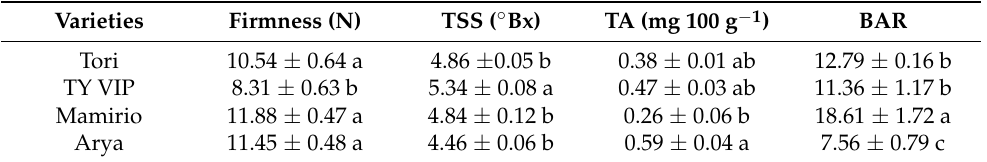
Table 1. Firmness, TSS, TA, and BAR of ‘Tori’, ‘TY VIP’, ‘Mamirio’, and ‘Arya’ tomato cultivars at the commercial pink ripening